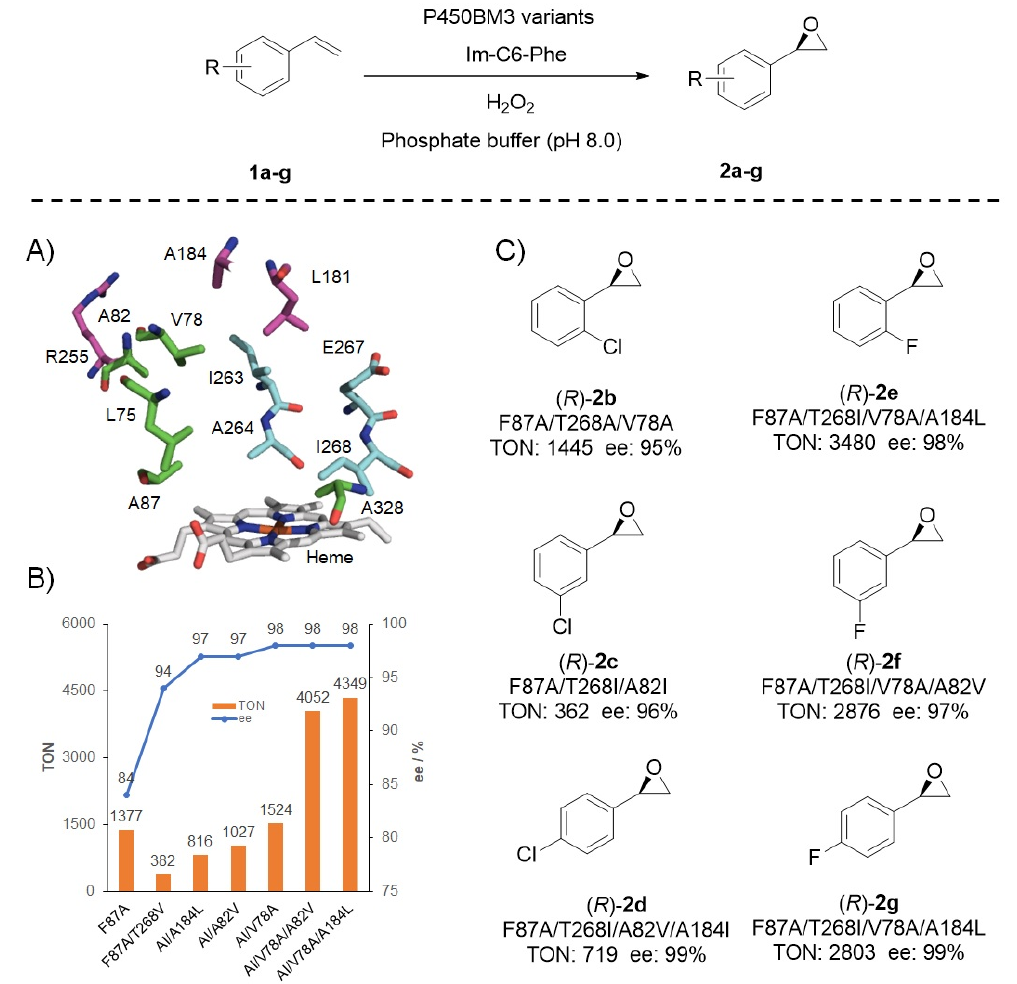
Figure 5. Protein engineering of the DFSM-facilitated P450BM3 peroxygenase for catalyzing ( R )- enantioselective epoxidation of styrene and its derivatives. ( A ) Key residues around the substrate- binding pocket of P450BM3; ( B ) protein engineering for styrene epoxidation; ( C ) the epoxidation of styrene derivatives by the DFSM-facilitated P450 peroxygenases.